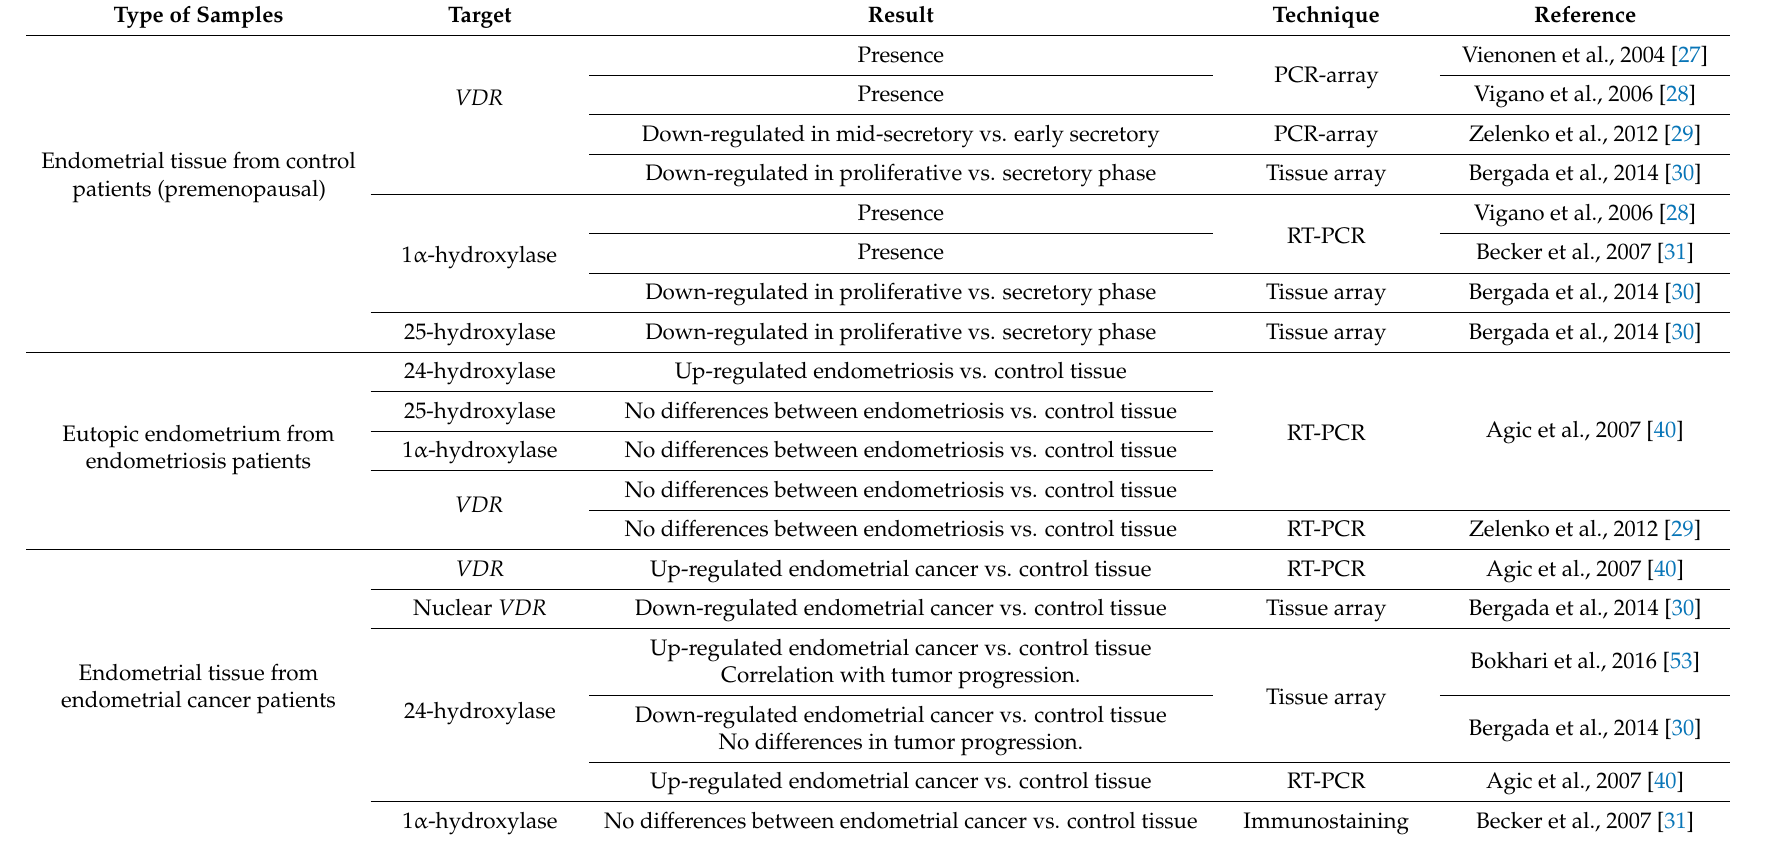
Table 1. Studies addressing the presence/absenceof VDR and enzymes that metabolized VD in normal and pathologic